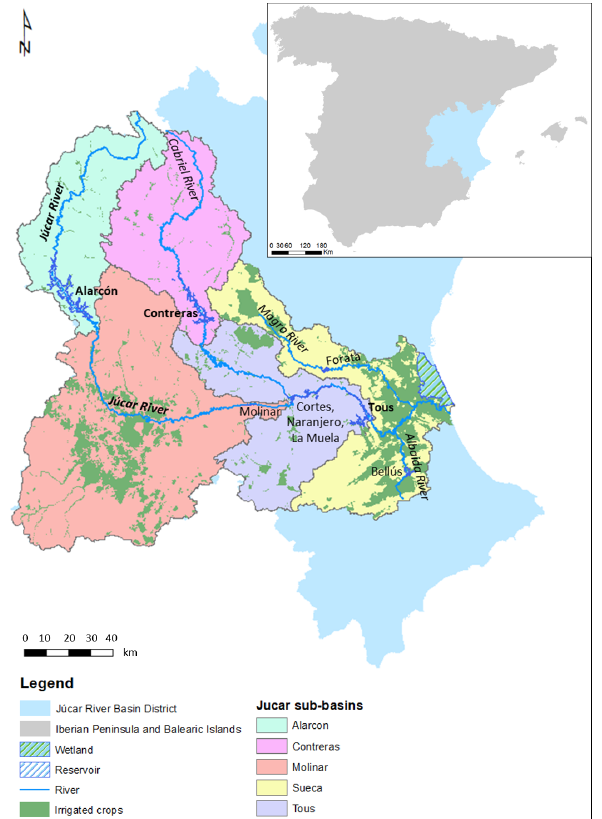
Figure 1. Location of the Júcar River Basin District and the Jú- car River basin (divided into sub-basins) in Spain. Source: Con- federación Hidrográfica del Júcar (CHJ, https://www.chj.es/es-es/ Paginas/Home.aspx, last access: 26 September 2019) and Instituto Geológico y Minero de España (IGME, http://www.igme.es/, last access: 26 September